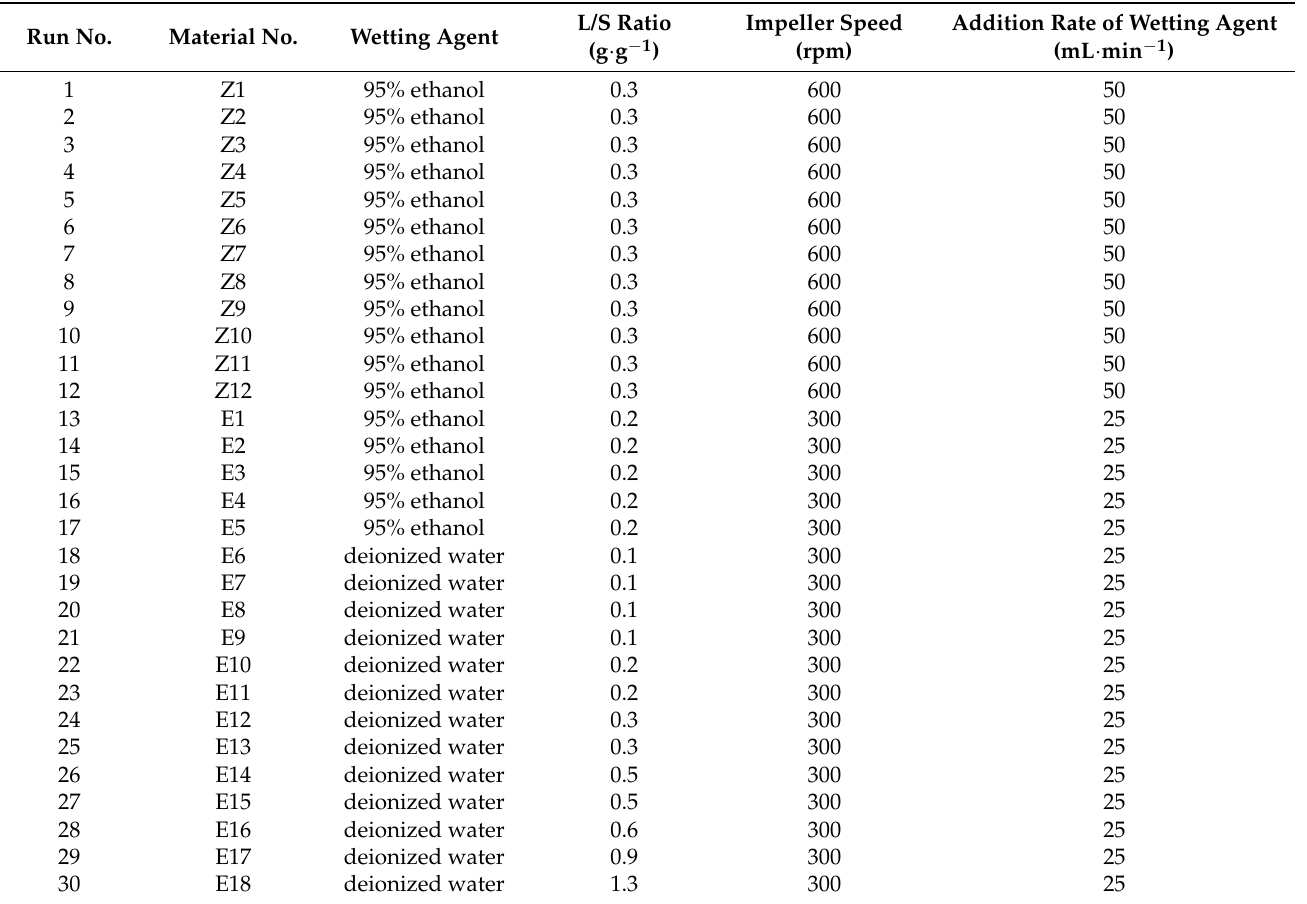
Table 1. The arrangements of experimental design for the high shear wet granulation